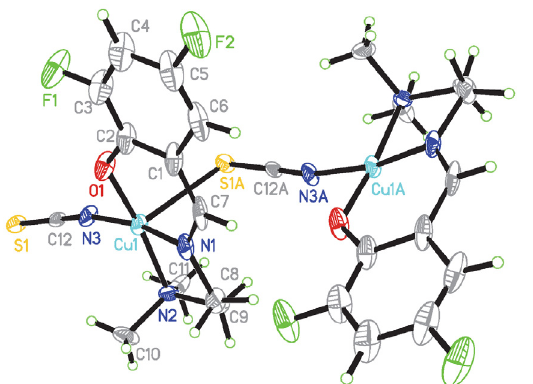
Figure 3. A perspective view of complex 3 with the atom labeling scheme. Thermal ellipsoids are drawn at the 30% probability level.